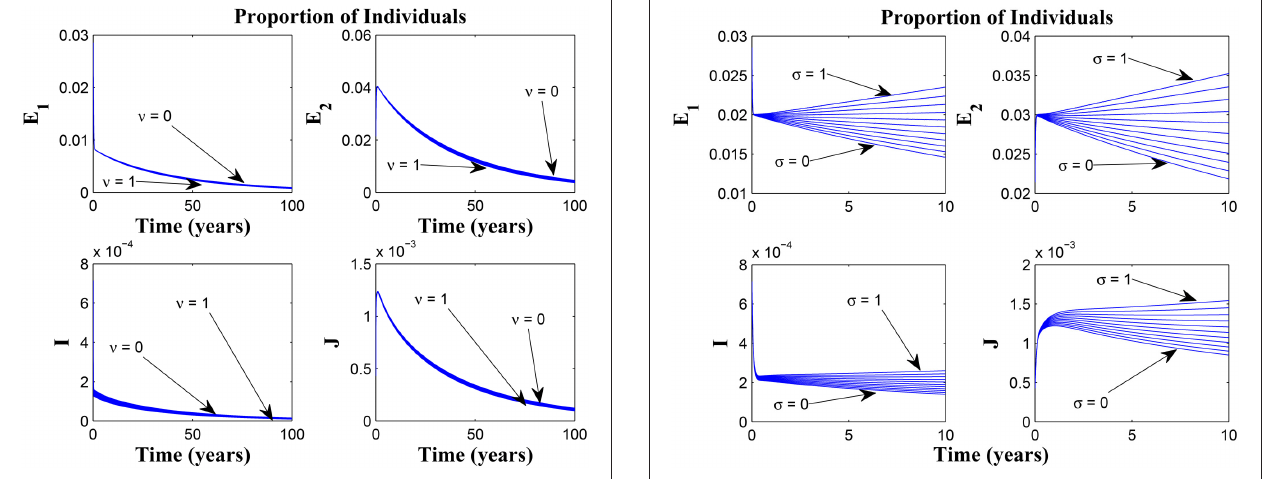
FIGURE 13 | Simulations of model (3) showing the number of infected individuals. Here, the cost factor ( ν ) is varied from 0 to 1 with α 1 = α 2 = 5 , θ 1 = θ 2 = 1 , ψ = 30 and π = 20 .